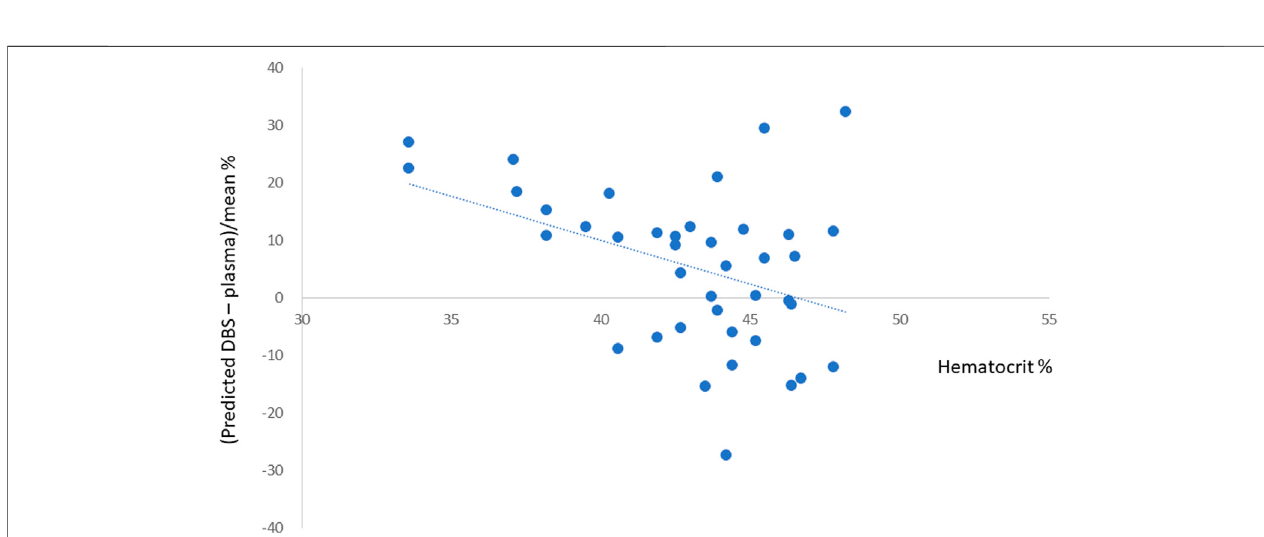
FIGURE 3 | The impact of hematocrit level to bias of DBS predicted dabigatran concentration.